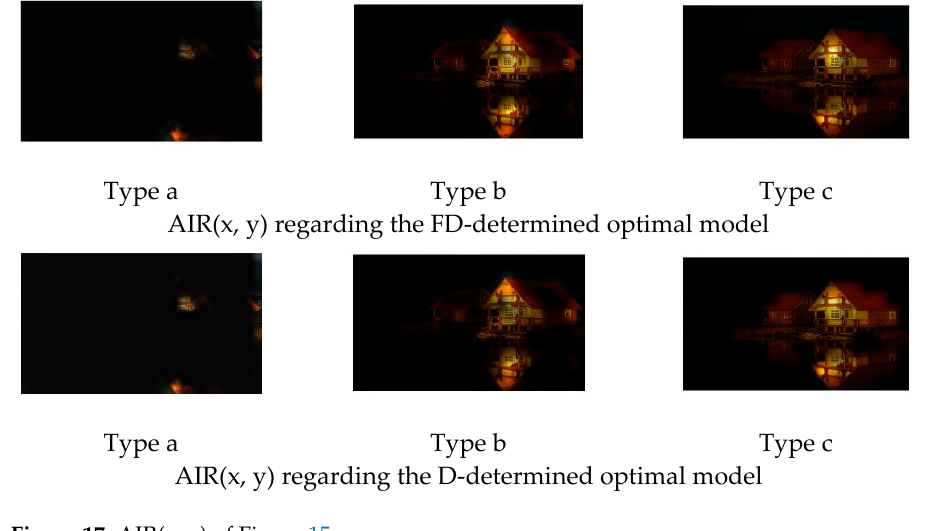
Figure 17. AIR(x, y) of Figure 15.